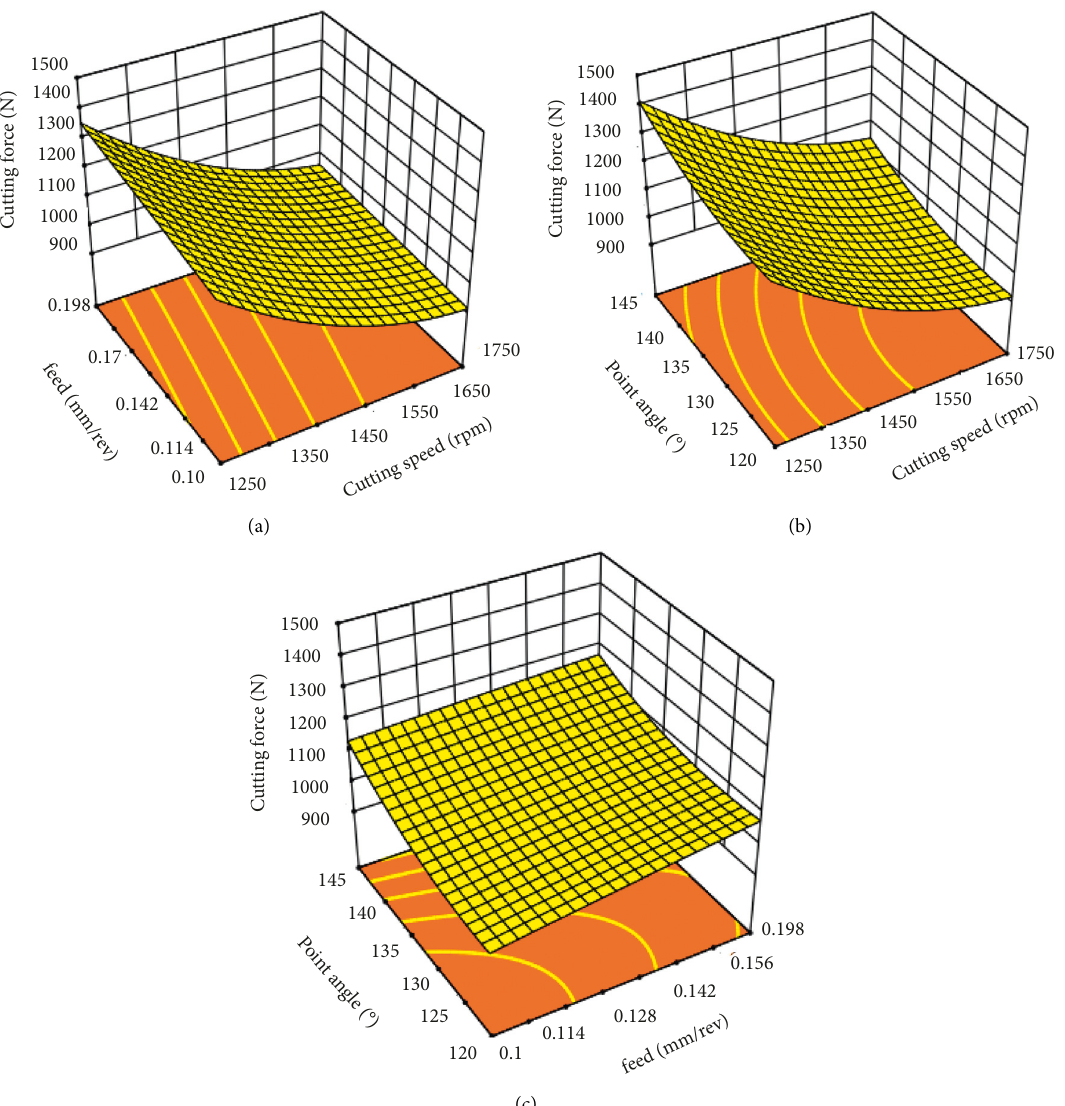
Figure 3: 3D plot for cutting force: (a) cutting speed vs. feed rate, (b) cutting speed vs. point angle, and (c) feed rate vs. point angle.